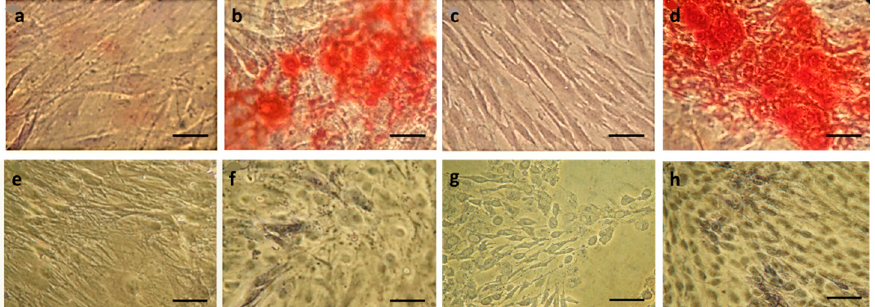
Figure 3. Alizarin red staining ( a – d ) and alkaline phosphatase staining ( e – h ) for the detection of differentiated mesenchymal cells to osteoblasts after treatment with aza-reversine 2 (100 nM) ( b , d , f , h ). Control cells were treated with DMSO < 1% ( a , c , e , g ). The mesenchymal cells were isolated from adipose tissue ( a , b , e , f ) or dental tissue ( c , d , g , h ). Positive staining for alkaline phosphatase and alizarin red shows that mesenchymal cells were differentiated into osteoblasts. The circular shape of the differentiated cells is also a morphological characteristic of the osteoblasts, while the shape of mesenchymal cells is rod-like. All images are taken using optical microscopy with 40 × magnification. Scale bars: 0.5 μ m.